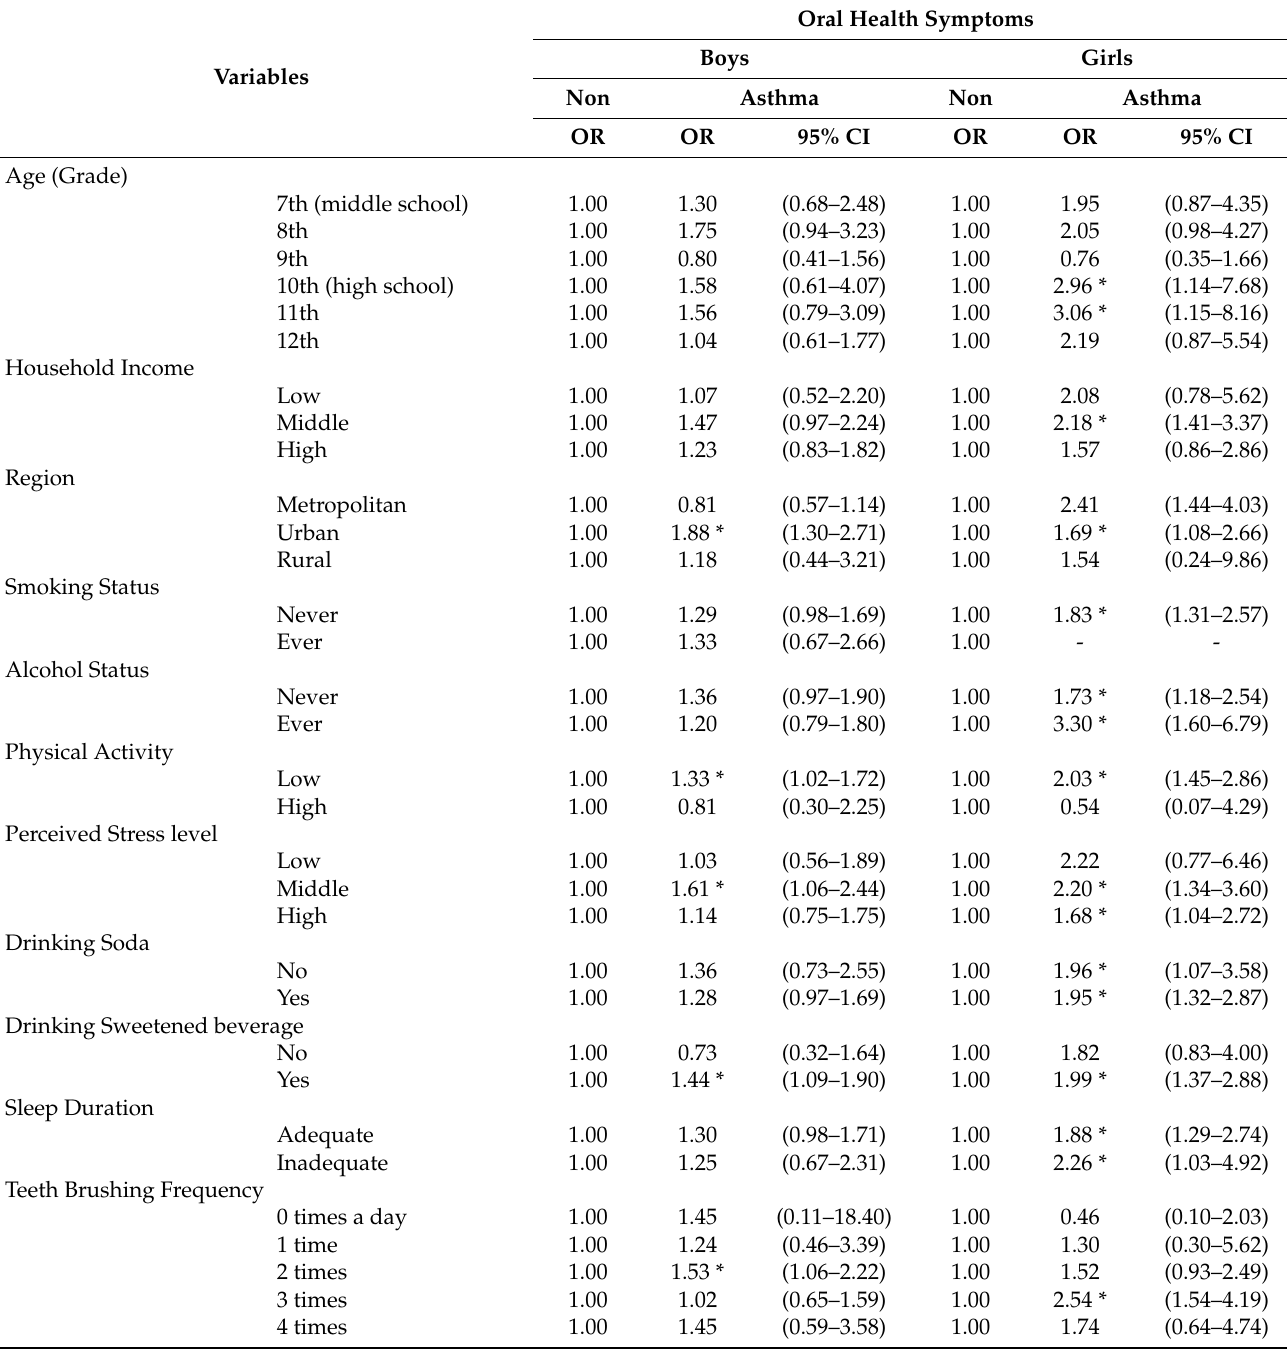
Table 3. Results of subgroup analysis stratified by independent